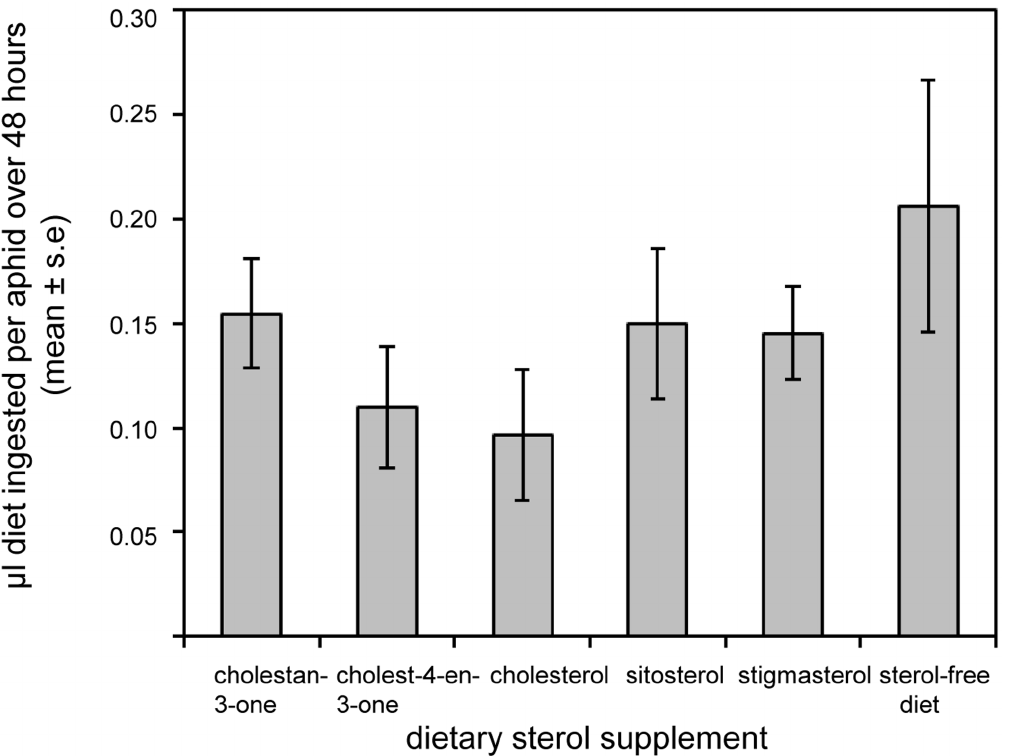
Figure 2. Volume of diet ingested by Myzuspersicae on sterol-supplemented diets. The experiments quantified radioactivity in the honeydew of aphids fed on diet supplemented with 14 C-inulin, which does not traverse the gut wall of these aphids.